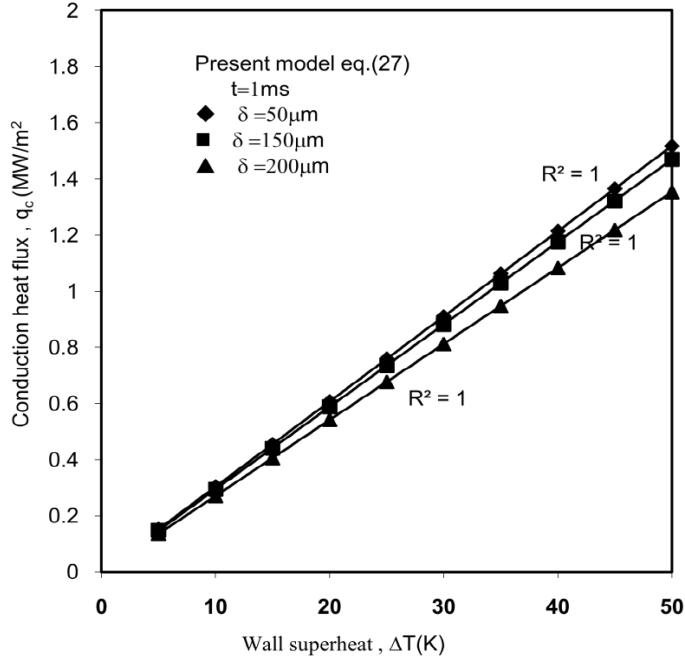
Figure 2. E ff ectof the wall superheat on the conduction heat flux for di ff erent macrolayer Figure 2. Effectof the wall superheat on the conduction heat flux for different macrolayer thicknesses.